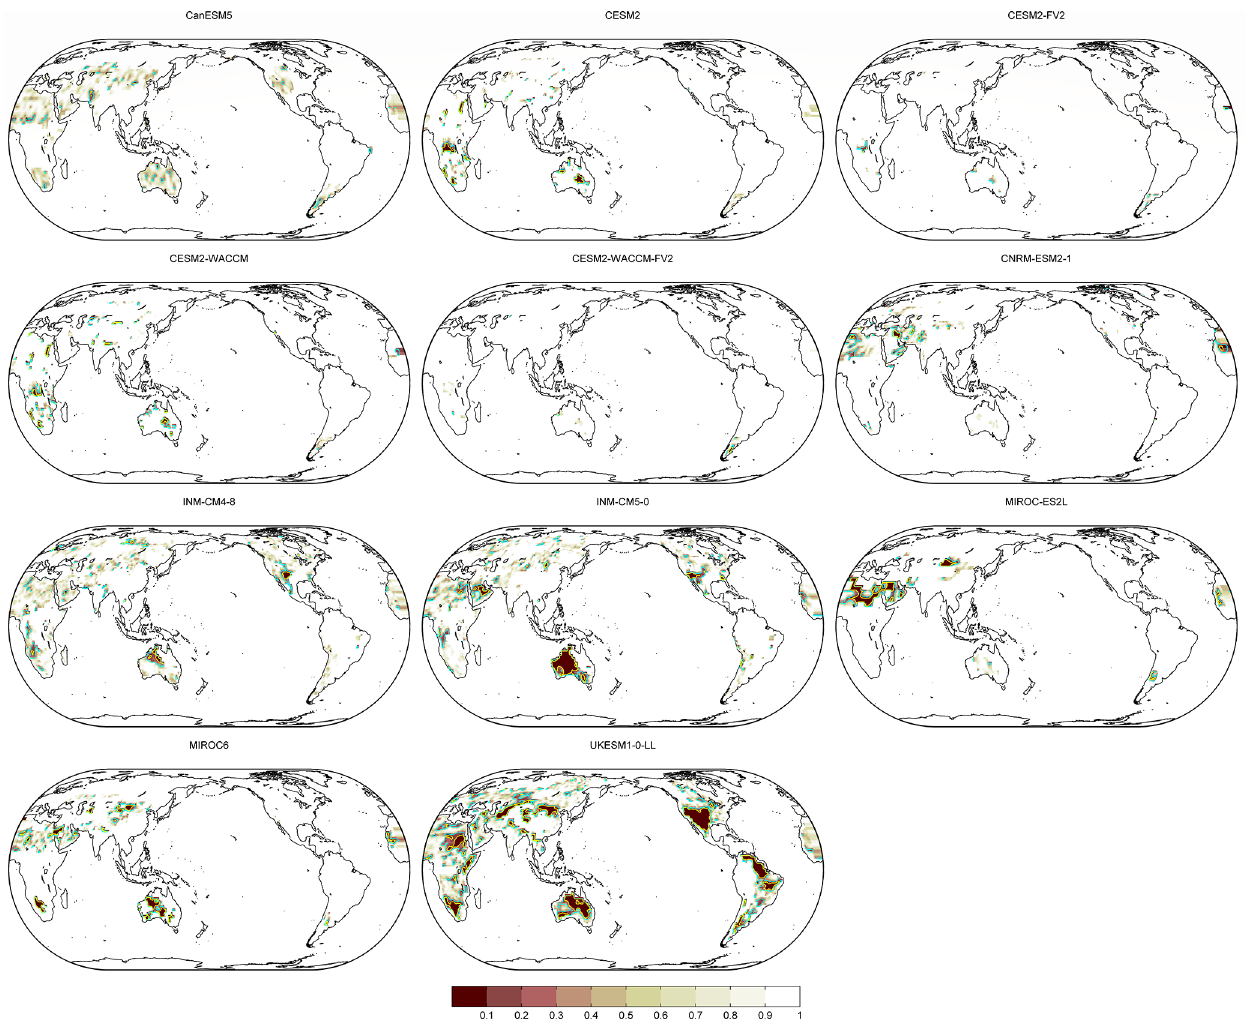
Figure 6. As in Fig. 1, except for the probability of the absence of Granger causality from ENSO and annual mean dust emission over the period 1850–2014 for the historical simulation of 11 different models (see Table S2). ENSO: El Niño–Southern